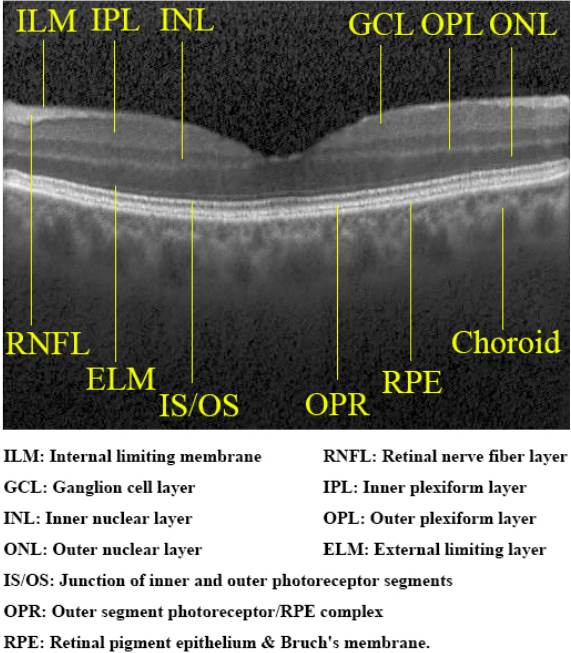
Figure 5. Retinal layers in a synthetic normal OCT image generated by our model. These layers are clearly distinguished and comparable with genuine images.